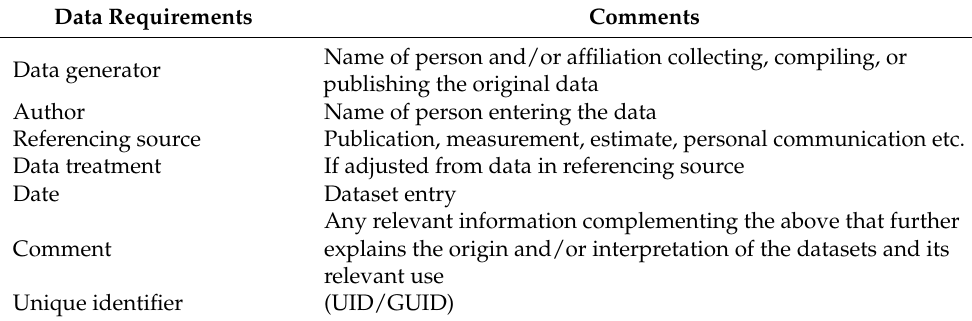
Table 2. Minimum requirements for data